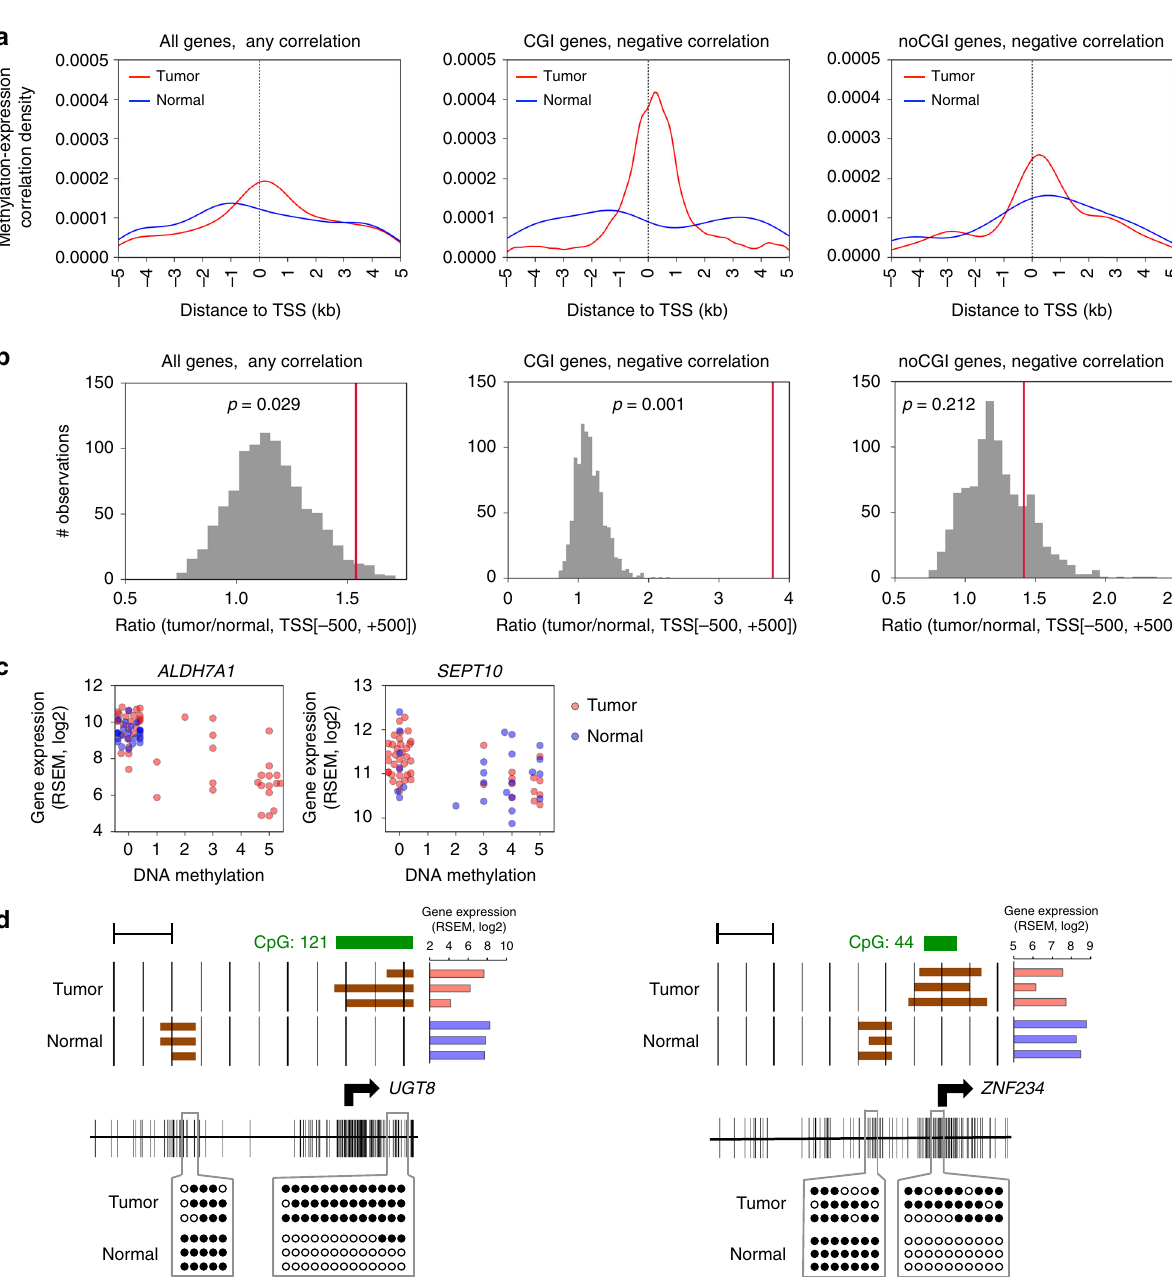
Fig. 2 Association of DNA methylation at TSS with gene expression in HPVOPSCC. a Methylation-expression correlation density plots showing where DNA methylation and gene expression are signi fi cantly correlated (FDR q < 0.05), demonstrating a strong, tumor-speci fi c association of expression with methylation at the TSS. Y -axis represents probability and the area under the curve (AUC) adds up to 1. Plots of any correlation in all genes ( n = 19866) in our discovery HPVOPSCC data set, and negative correlation in genes with and without promoter-associated CpG island (CGI genes ( n = 13158) and noCGI genes ( n = 6708), respectively) are shown. b Signi fi cance of DNA methylation expression associations in tumor. The red line represents the observed AUC ratio (tumor/normal) at TSS ± 500 bp region. Histogram represents the null distribution as calculated by multiple permutations ( n = 1000). Results of any correlation in all genes, and negative correlation in CGI genes and noCGI genes are shown. c Scatter plots of two representative genes for expression and DNA methylation levels at the most signi fi cantly correlated 500 bp window determined by MBD-seq. d Bisul fi te sequencing con fi rmation of MBD-seq data from each two regions of two representative genes. The arrow indicates the TSS of each gene. Brown bars in the upper panel indicate binary methylation value at each 100 bp segment determined by MBD-seq. Red and blue bars show mRNA level determined by RNA-seq. Vertical lines in the lower panel represent CpG sites. Open and fi lled circles denote unmethylated and methylated CpG sites determined by bisul fi te sequencing,